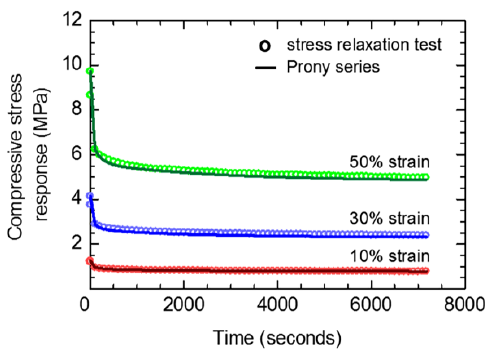
Figure 10. Comparisons between compressive stress responses of disc-A during viscoelastic period estimated from Prony series and those of experiments.